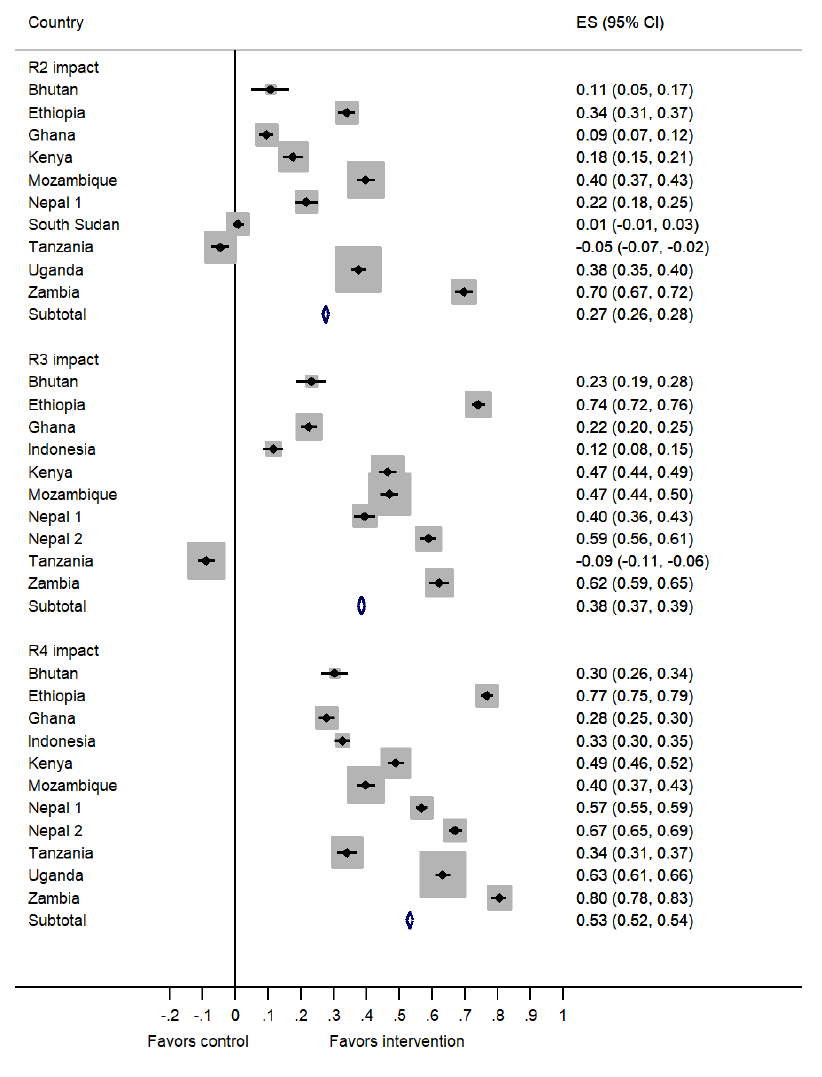
Figure A1. Forest plot showing the impact of the SSH4A interventions on basic latrine coverage, weighted by population size. ES—estimate of prevalence difference compared to baseline.